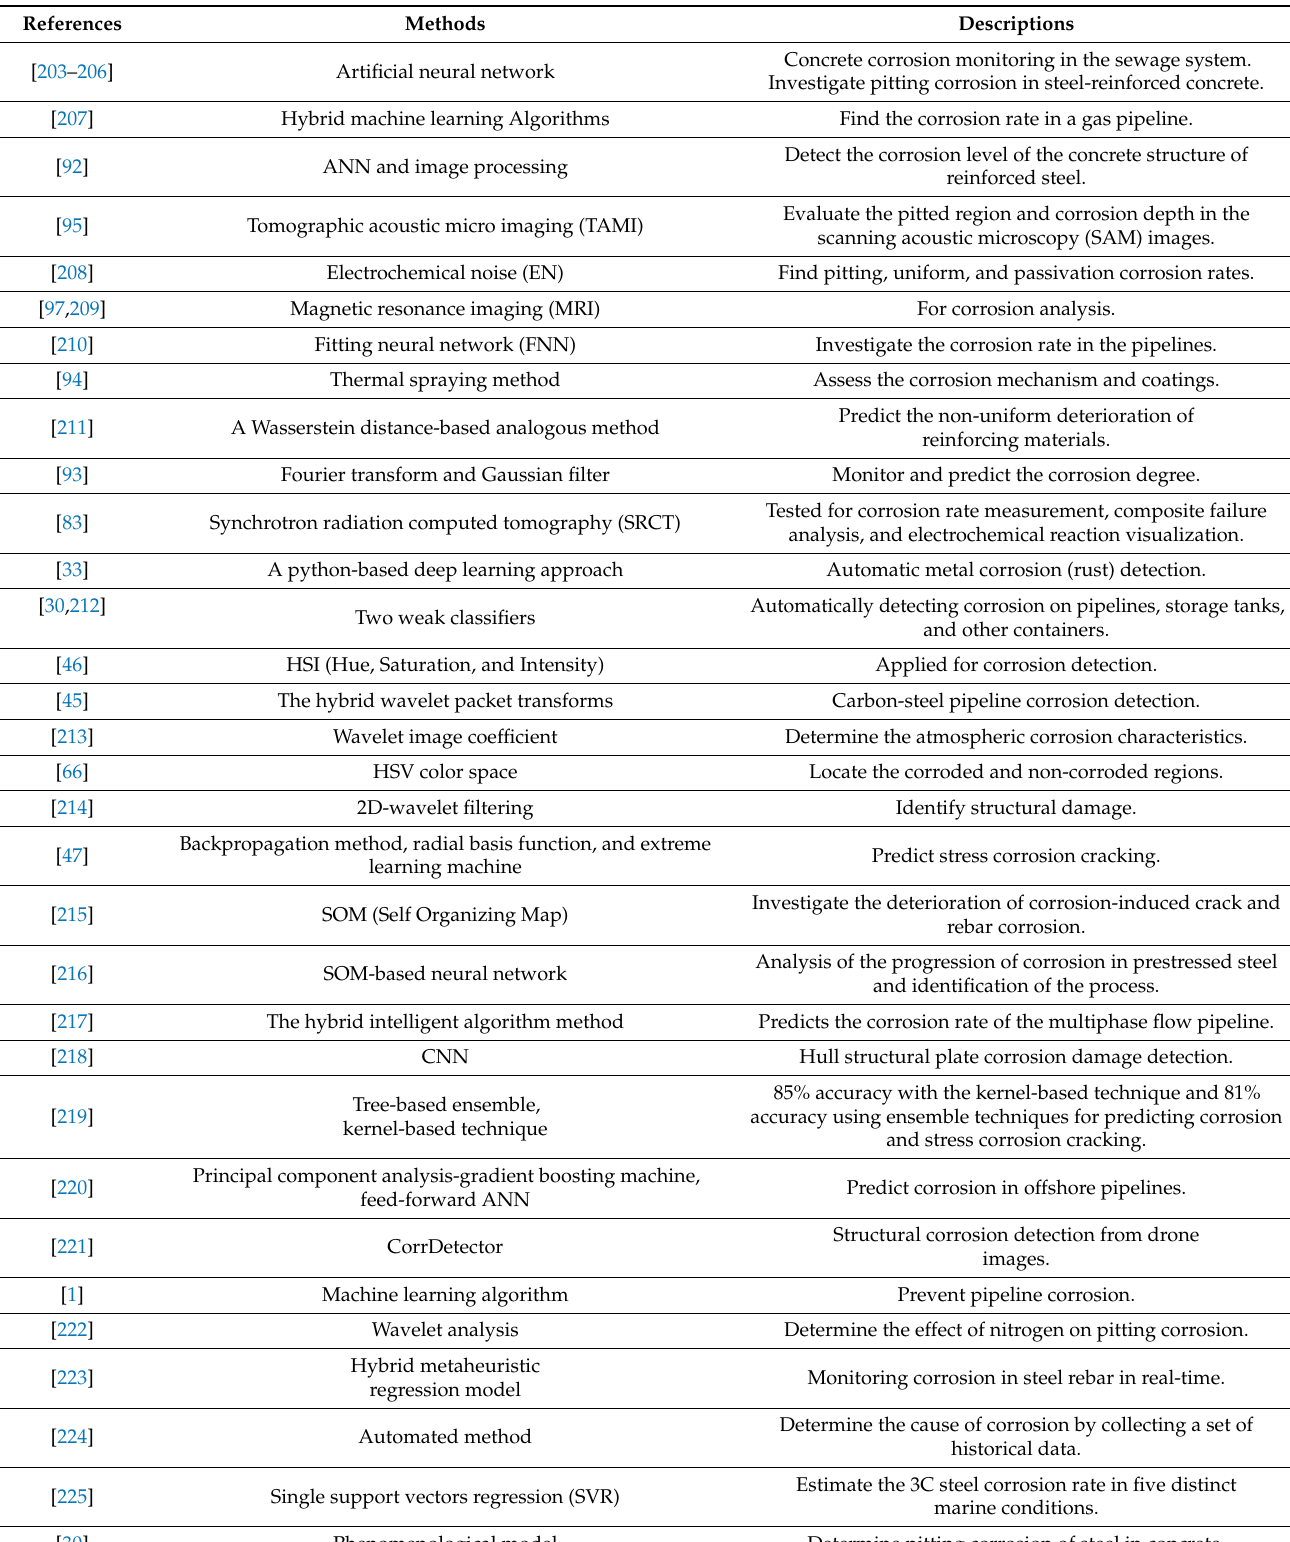
Table 5. Other corrosion detection